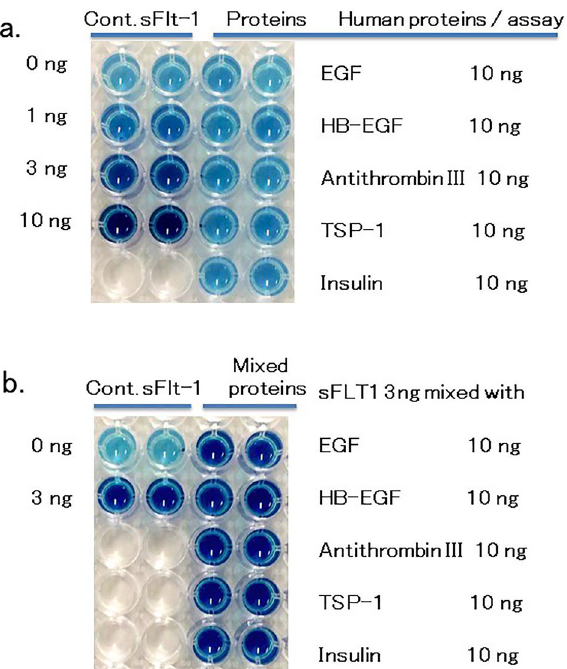
Figure 5. Validation assay was carried out with 5 human proteins: EGF, HB-EGF, Antithrombin III, TSP-1 and Insulin. ( a ) 10 ng of these proteins were assayed with sFLT1 HB-ELISA. The values detected were: 0 ± 0.55, 0.37 ± 0.31, 0.24 ± 0.18, 0.46 ± 0.17, and 0.23 ± 0.03, respectively. ( b ) 10 ng of these proteins were mixed with control 3 ng of sFLT1, and assayed with sFLT1 HB-ELISA. The values detected were: 2.88 ± 0.32, 3.19 ± 0.77, 2.98 ± 0.10, 3.08 ± 0.22, and 2.84 ± 0.08,